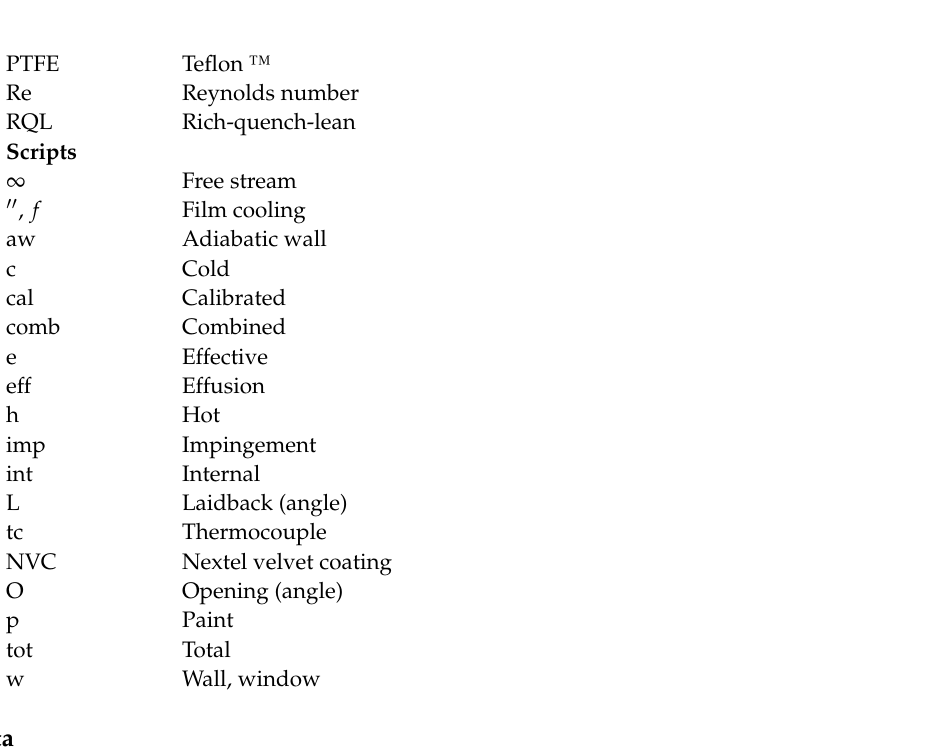
Table A1. Standard deviations of hot gas side Nusselt number for each of the averaged data points shown in Figure 7. M = 1 M = 2 M = 3 Wind. # Wind. # Wind. # MALO00